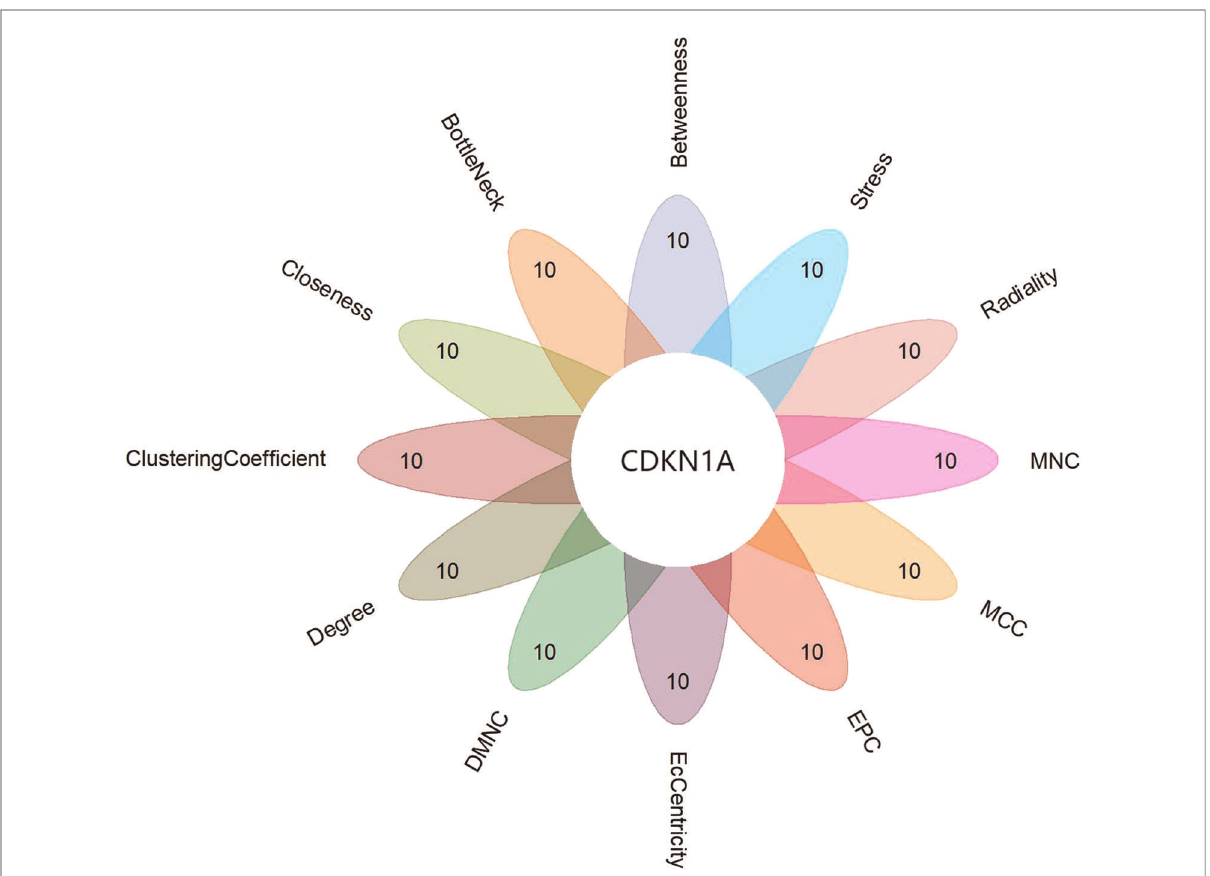
FIGURE 6 Flower plot for cytohubb results. Each petal represents one of cytohubb ’ s algorithms, and only CDKN1A generemains after taking the